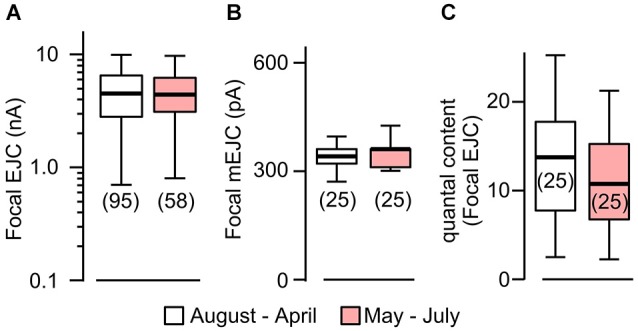
Focal mEJCs and EJCs were not affected by rearing temperature. Focal EJCs (A) and mEJCs (B) remained stable despite ambient temperature fluctuations. Building temperature varied significantly: from as low as 15°C to beyond 30°C (mostly during May to July). Pooled data from August to April are compared to those from May to July. (C) Quantal content of the focal EJCs was not different between the two periods (p > 0.5, Wilcoxon rank-sum test). Number of recording sites indicated in parenthesis. (A) is reconstructed from data in Ueda and Wu (2012).